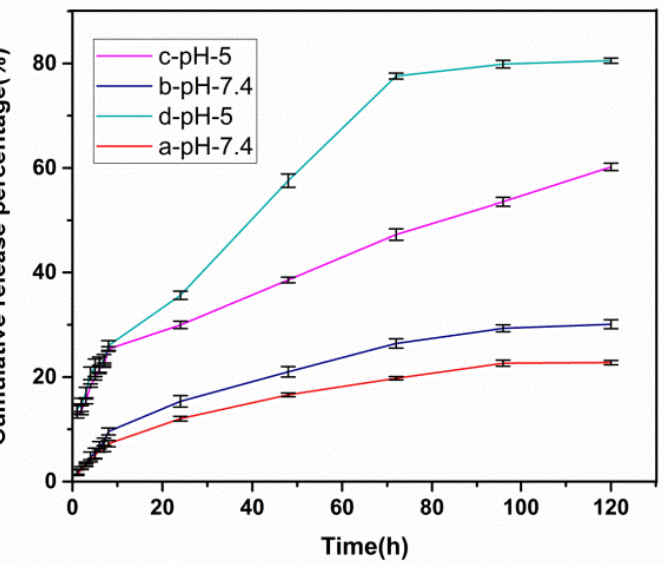
Figure 6. Cumulative release curves of naproxen from naproxen-loaded Ni 1−x Co x Fe 2 O 4 @Methionine NPs at pH 5 ( c ) and pH 7.4 ( b ); Ni 1−x Co x Fe 2 O 4 @Methionine@PEG NPs at pH 5 ( d ) and pH 7.4 ( a ). Data are expressed as mean ± SD ( n = 5). Table 1. The release kinetic models and the parameters obtained for the carriers.